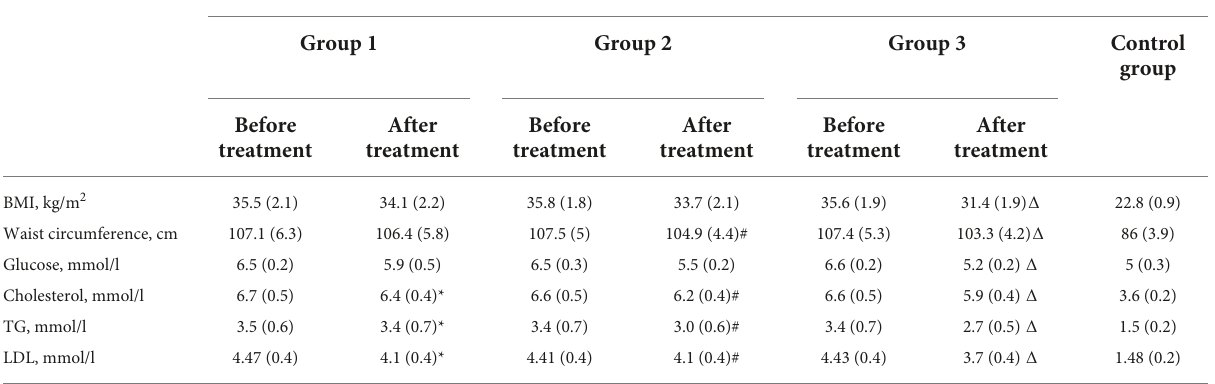
TABLE 2 Comparative characteristics of patient groups according to anthropometric parameters and the results of the examination of carbohydrate and lipid metabolism after treatment (Student’s t -test). Parameter Number of cases, % Group 1 Group 2 Group 3 Control group Before After Before After Before After treatment treatment treatment treatment treatment